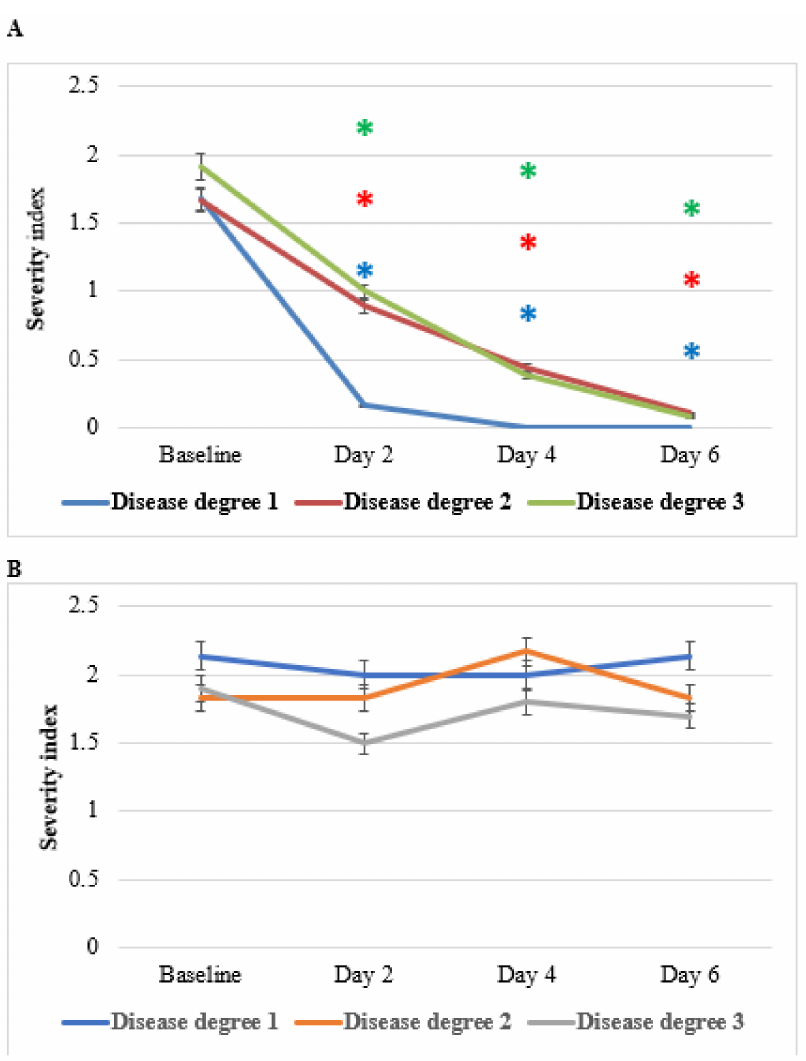
Figure 11. Effect of anti-hemorrhoidal polyherbal cream (HPC) on itching severity. Disease degree 1 (HPC, n = 19; placebo, n = 7), 2 (HPC, n = 9; placebo, n = 6), and 3 (HPC, n = 26; placebo, n = 10). * p < 0.01—significant as compared with